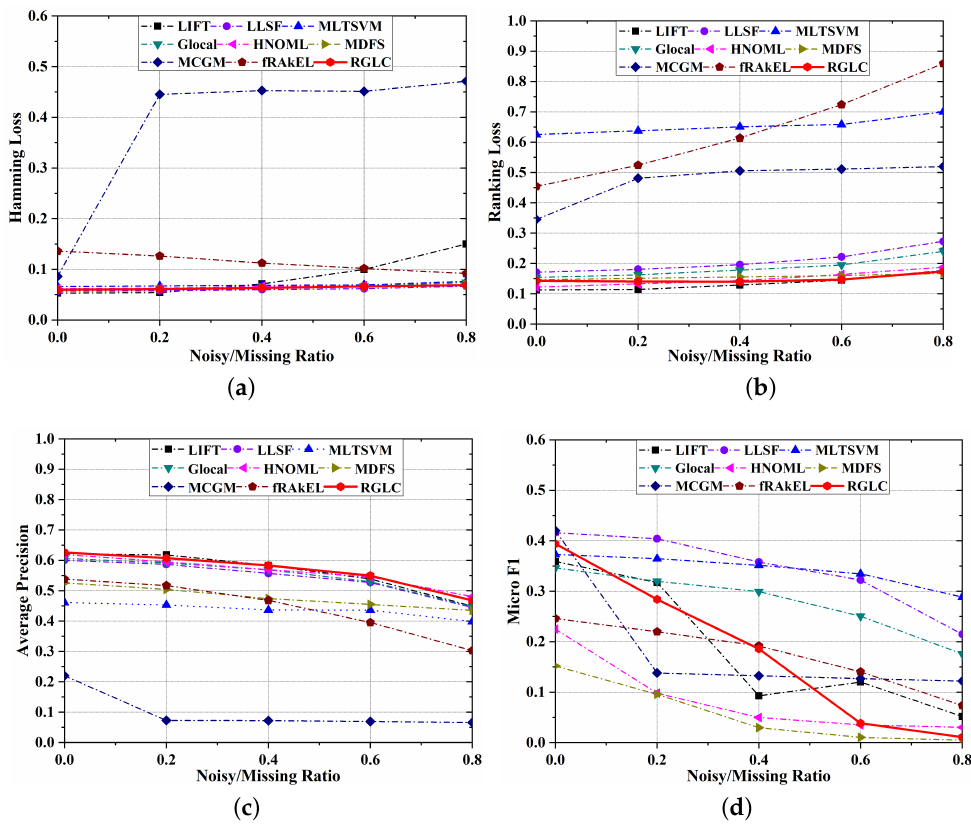
Figure 2. Robustness experiments with noisy features and missing labels on dataset art on metric ( a ) Hamming Loss , ( b ) Ranking Loss , ( c ) Average Precision , and ( d ) Micro F1